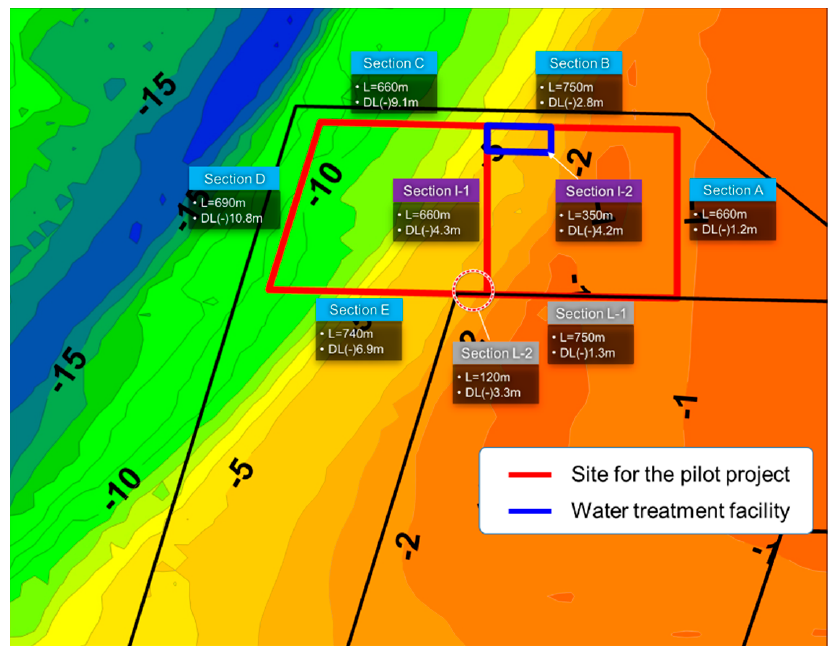
Figure 4. Details of the revetments constituting the proposed offshore waste disposal facility.